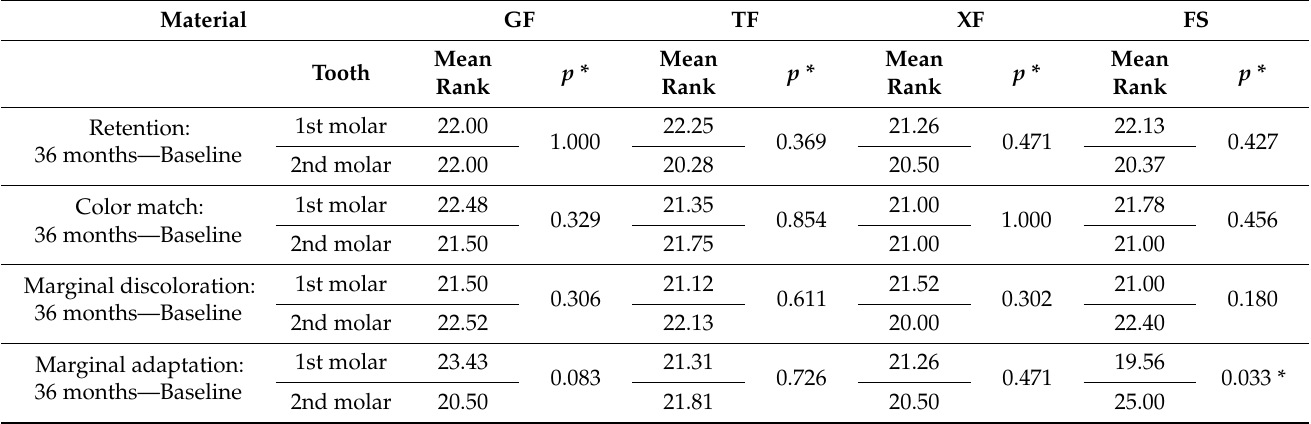
Table 6. Analysis of tested materials considering USPHS criteria and 1st or 2nd